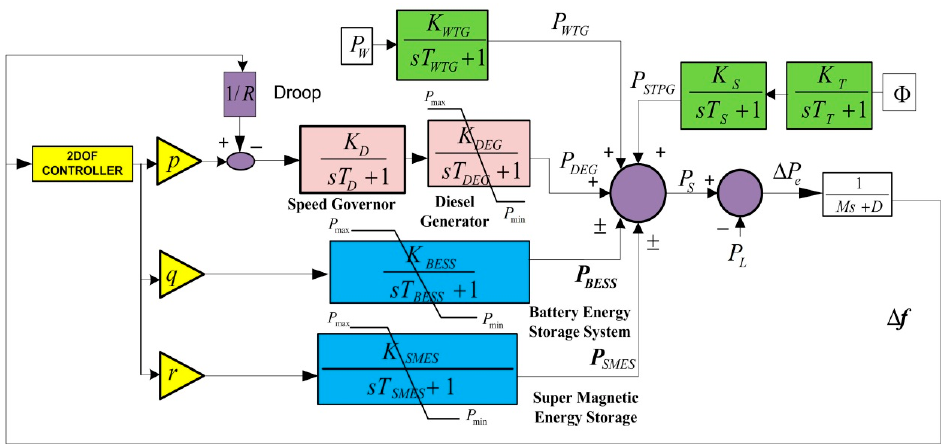
Figure 9. Linearized frequency response model of the WTG–STPG–DEG–BESS–SMES integrated autonomous hybrid energy network.